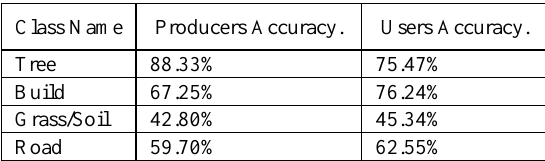
Table 3: Producer and User Accuracies of the Pixel-Based